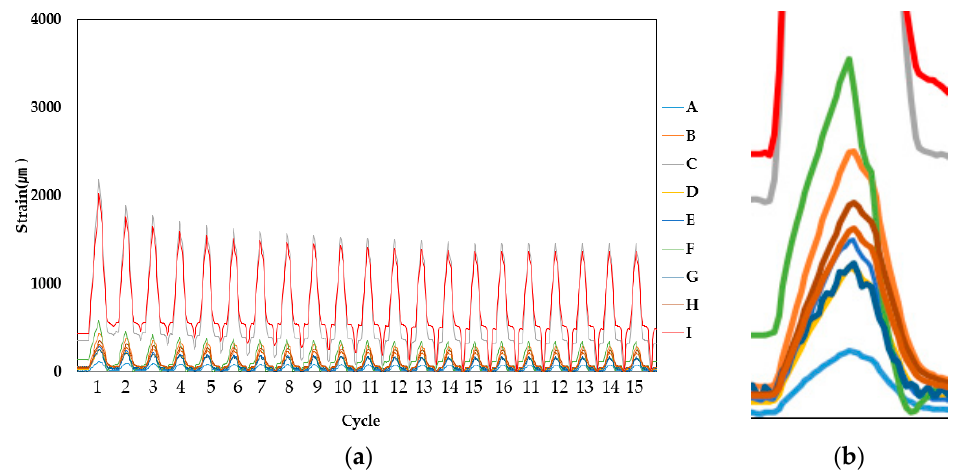
Figure 7. PUC (Specimen 1, 1.5 mm specimen sample) strain measurement result: ( a ) overall result and ( b ) single peak results of upper and lower section strain, magnified.